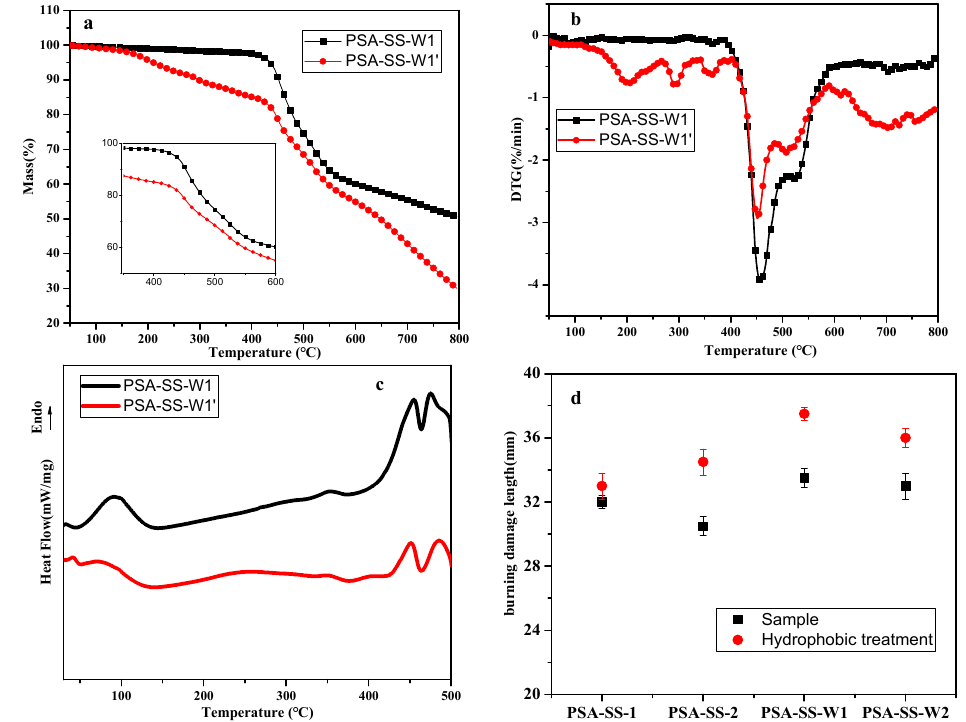
Figure 7. ( a–c ) The effect of hydrophobic treatment on thermal properties of fabrics; ( d ) the effect of hydrophobic treatment on fabric burning damage length. Table 3. The Thermogravimetric analysis (TG) and differential thermogravimetry analysis (DTG) data of fabrics under a nitrogen atmosphere as related to the employment of hydrophobic treatment.